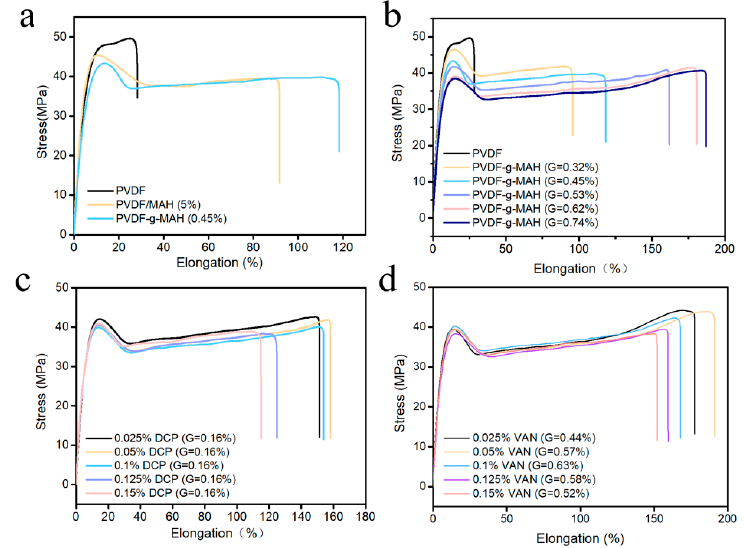
Figure 5. Mechanical properties of PVDF, PVDF/MAH and PVDF-g-MAH: ( a ), Comparison of tensile properties between PVDF, PVDF/MAH and PVDF-g-MAH; ( b ), comparison of tensile properties of grafts with different initial amounts of MAH; ( c ), comparison of tensile properties of grafts with different initial amounts of DCP; ( d ), comparison of tensile properties of grafts with different initial amounts of VAN.